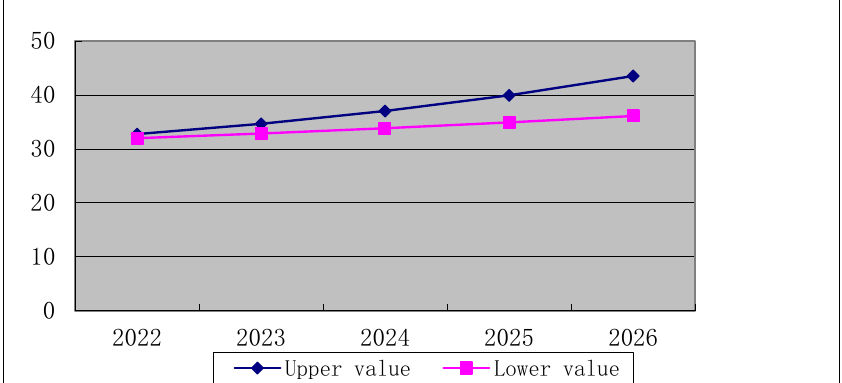
Figure 8. The variation interval of water requirement with the influence of the tertiary industry in Tianjin.